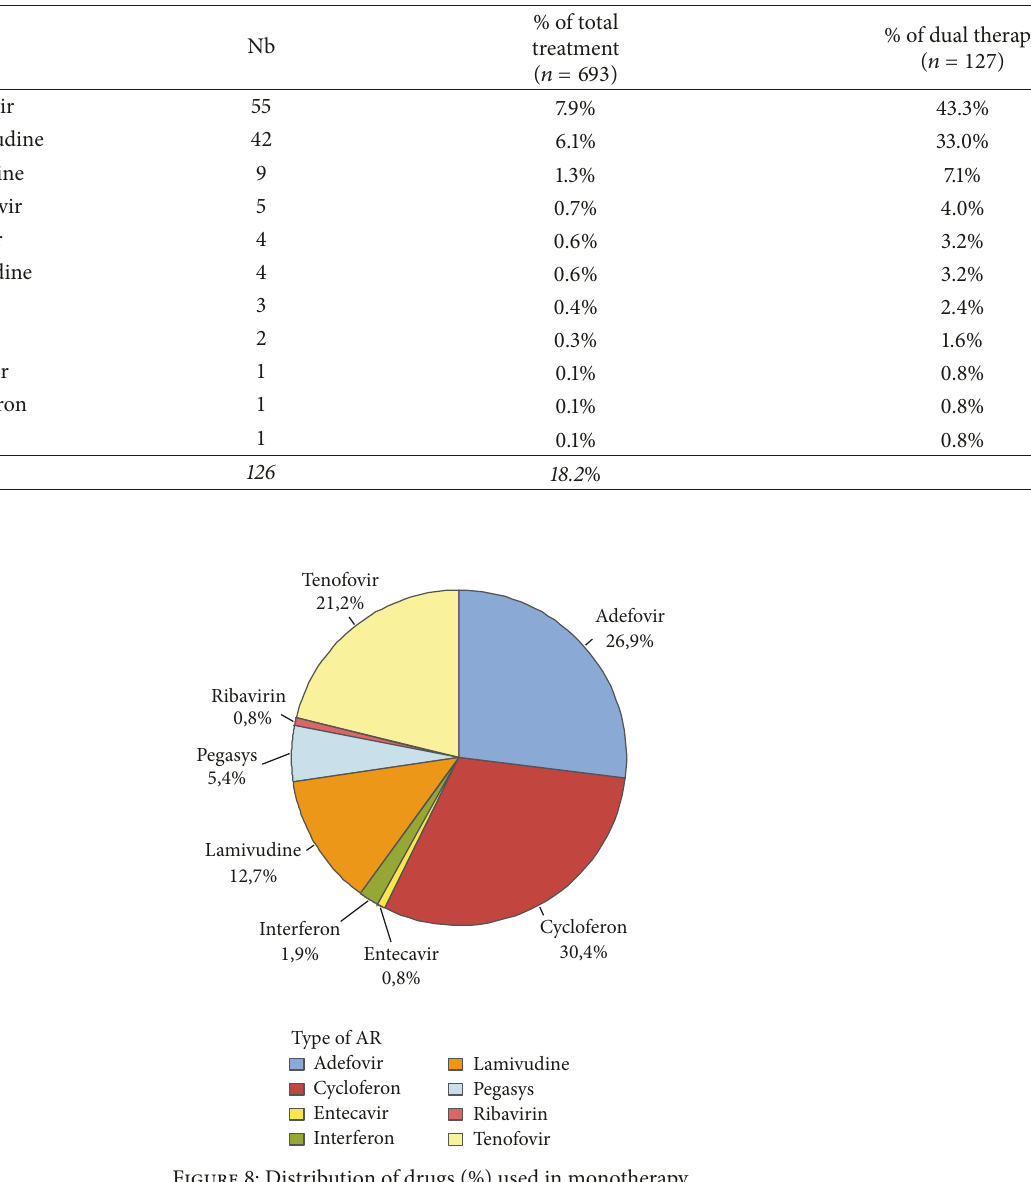
Table 1: Type of drugs, number, and % on total and dual treatments.